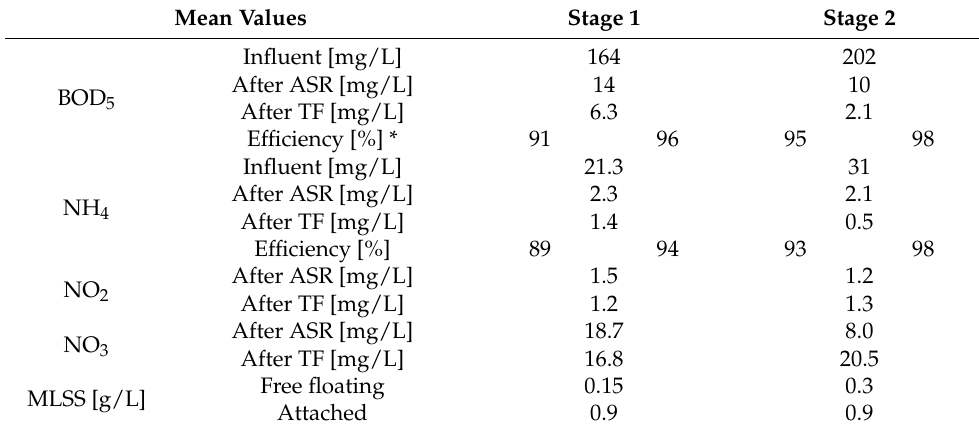
Table 2. Comparison of treatment process at stage 1 and 2 of the research.